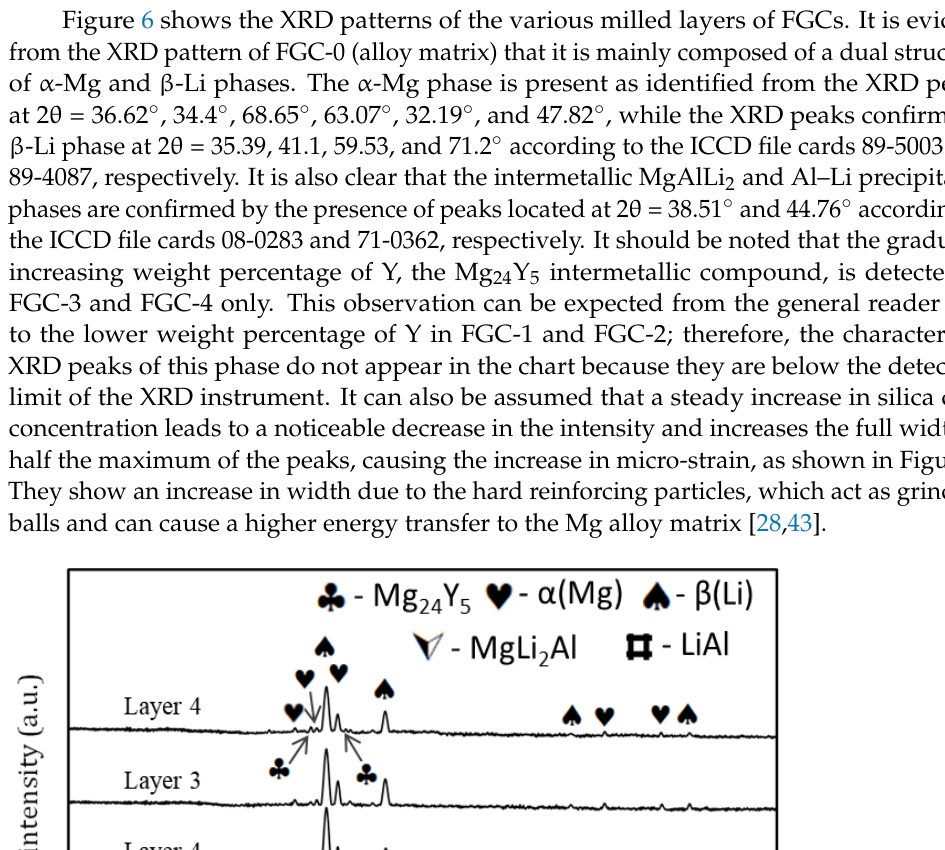
Figure 5. Particle sizes of FGC-0, FGC-1, FGC-2, FGC-3, and FGC-4 nanopowders after 20 h of grind- ing.